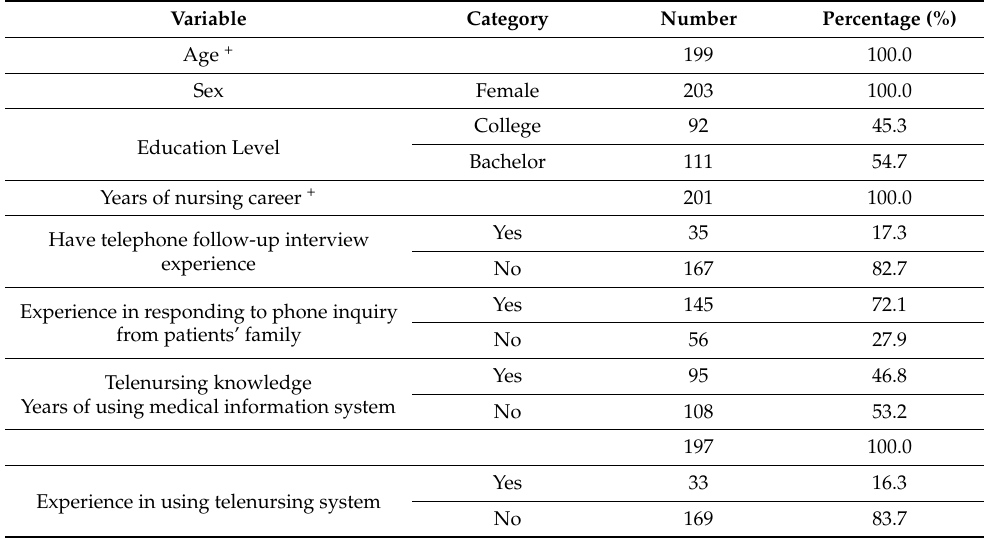
Table 1. Socio-demographic characteristics of the research sample ( n =